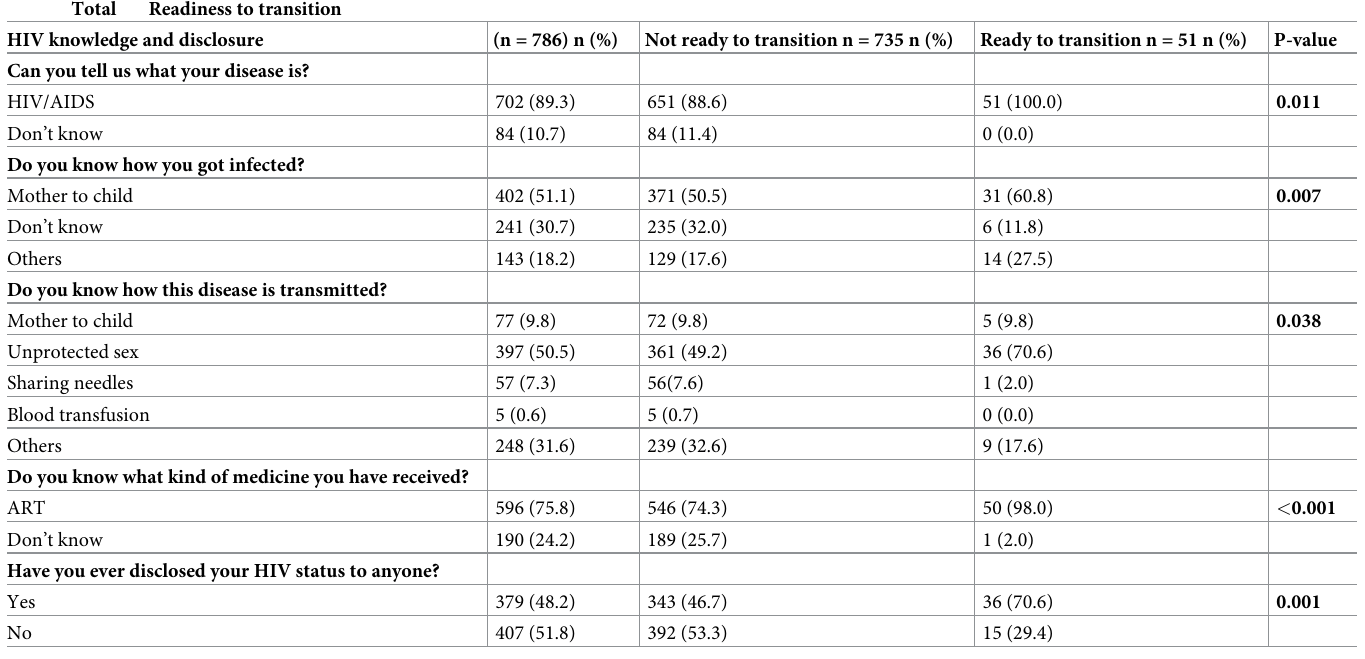
Table 3. Awareness and HIV status disclosure among adolescents living with HIV and their readiness to transition into adult ART services.